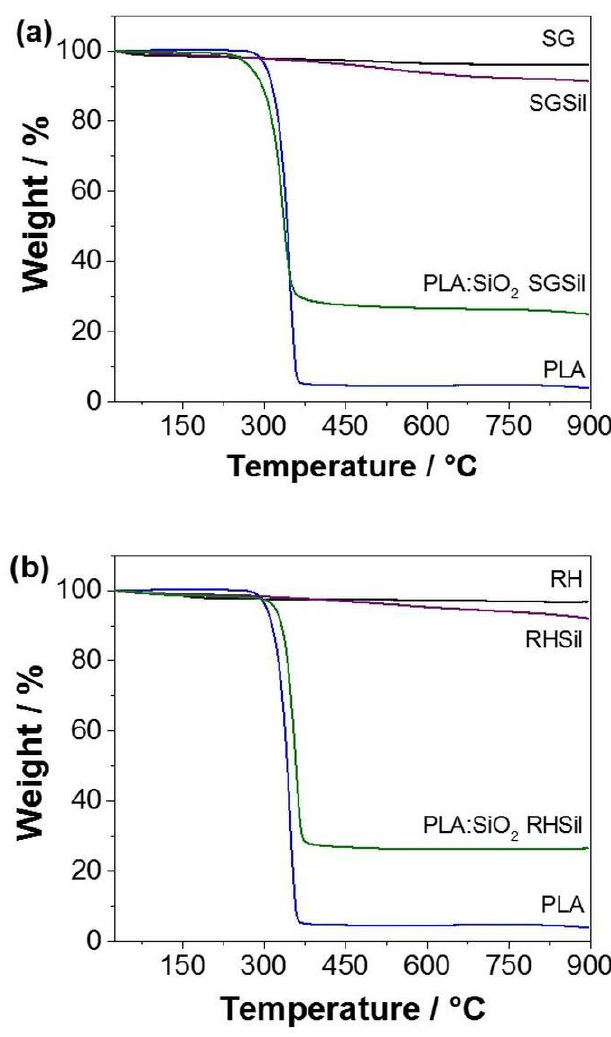
Figure 9. Thermogravimetric analysis of PLA:SiO 2 membranes: ( a ) SGSil and ( b ) RHSil.